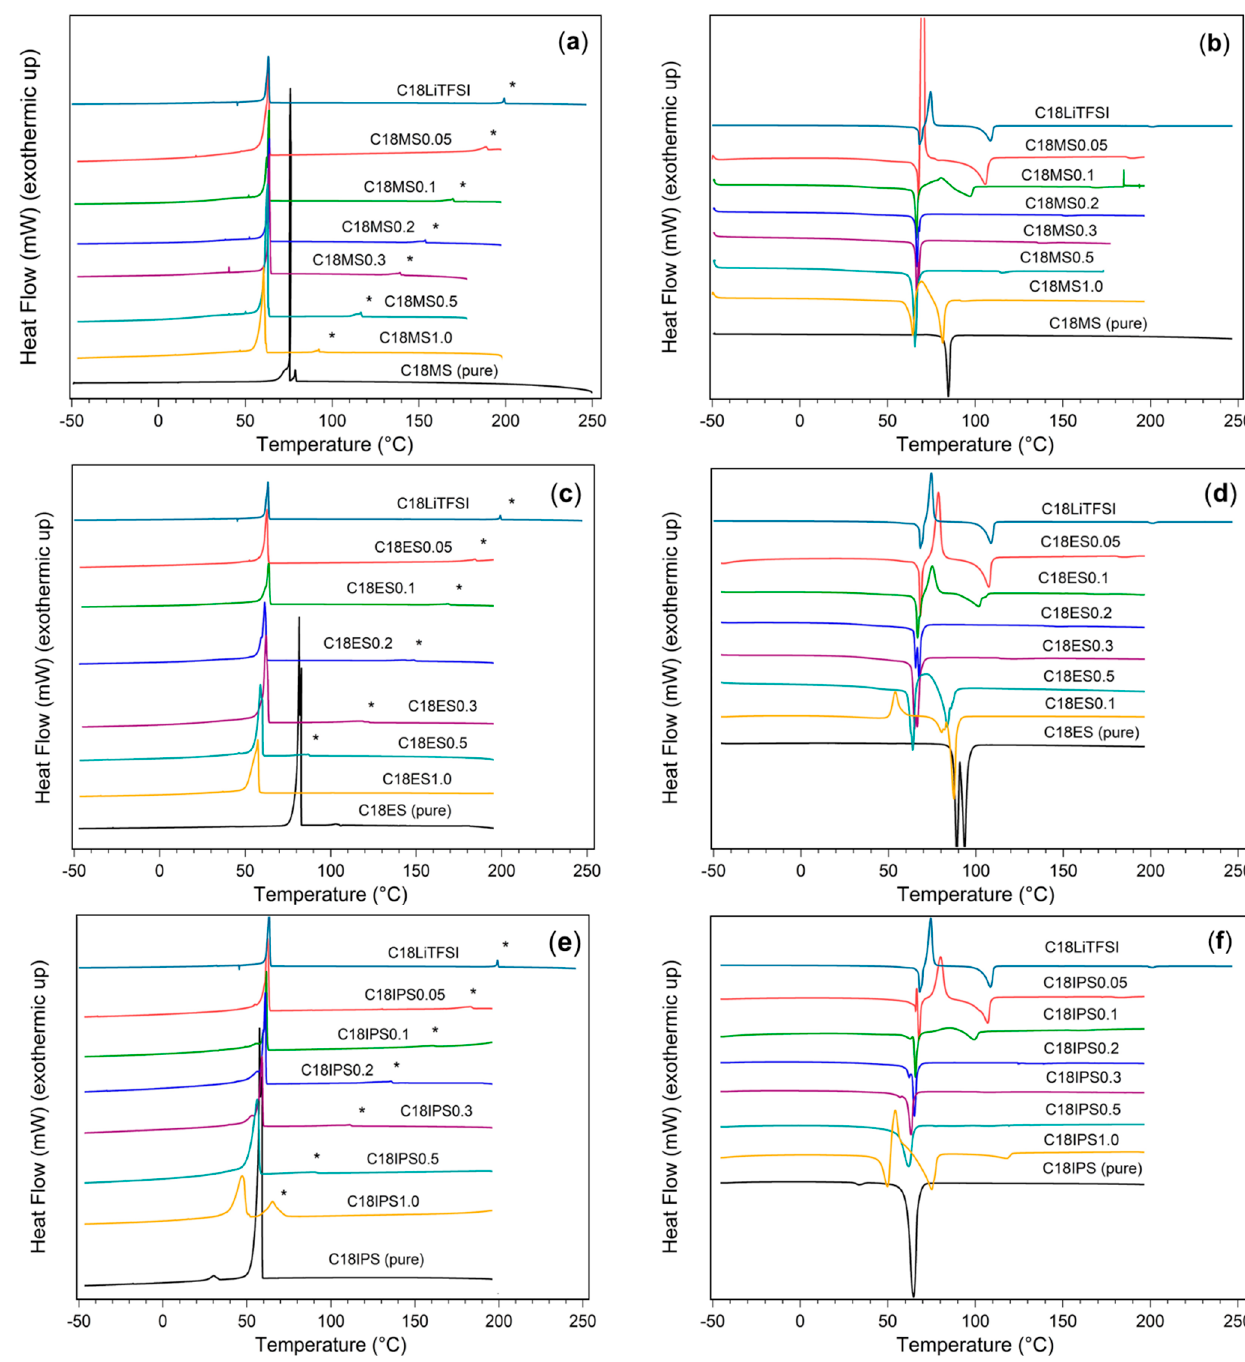
Figure 2. DSC scans for mixed ratios of additive molecules and C18LiTFSI in addition to pure additive on first cooling and second heating cycles. ( a ) C18MS cooling, ( b ) C18MS heating, ( c ) C18ES cooling, ( d ) C18ES heating, ( e ) C18IPS cooling, and ( f ) C18IPS heating show exothermic transitions pointed up. On the cooling cycles, isotropic to smectic transitions are indicated by *. Data for C18LiTFSI were originally reported in [21].